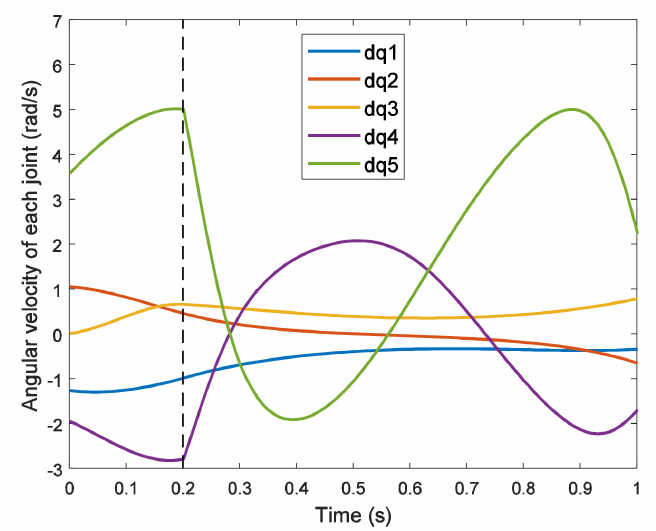
Figure 5. Trajectories of angular